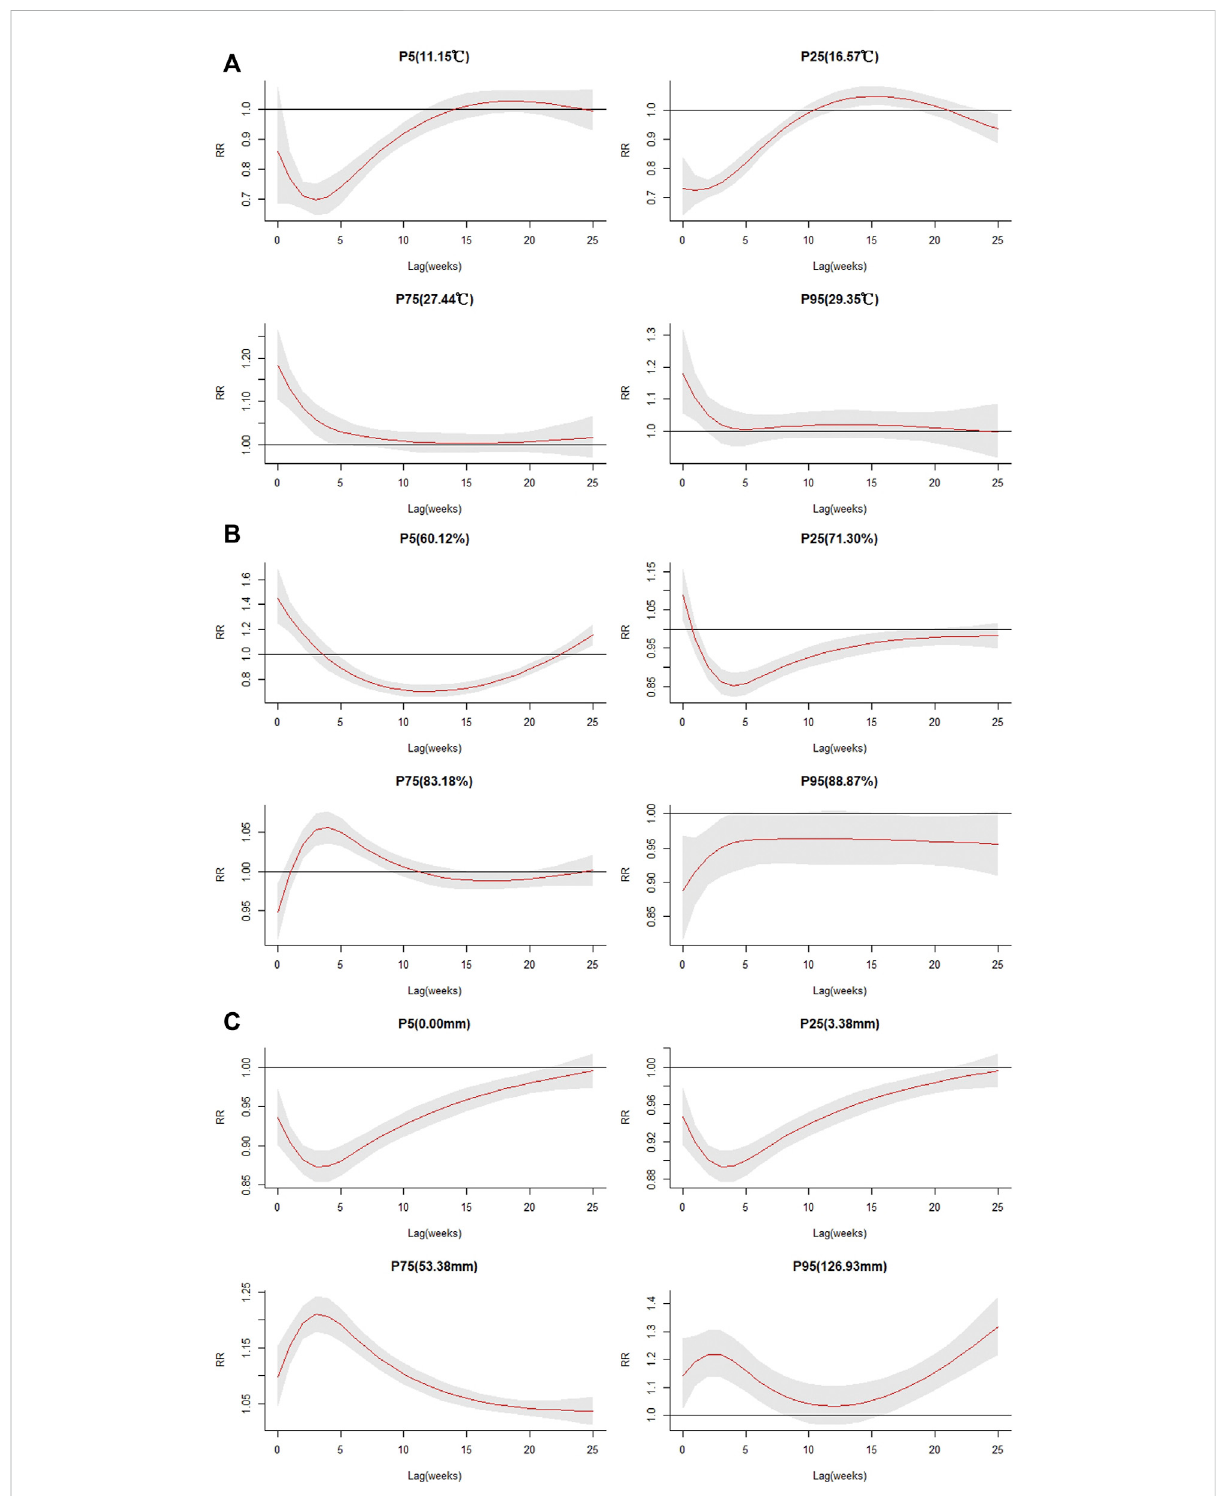
FIGURE 5 Plots of relative risk by lag for speci fi c meteorological factors. (A) weekly mean temperature; (B) weekly mean relative humidity; (C) weekly cumulative